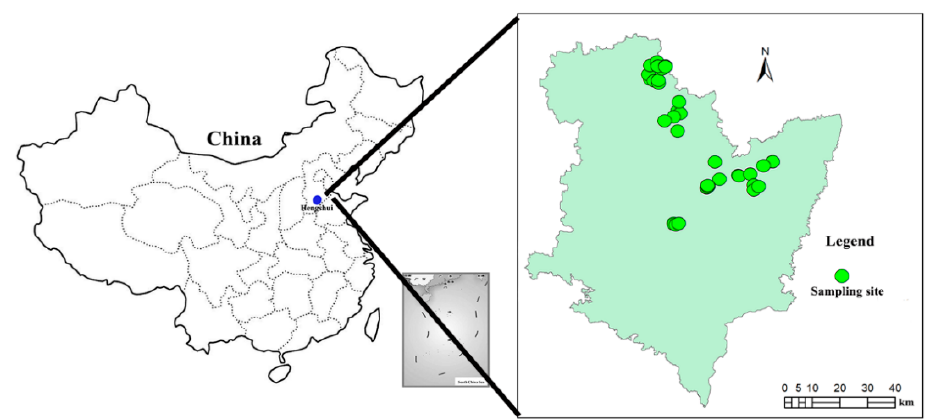
Figure 1. The study area and sampling site.